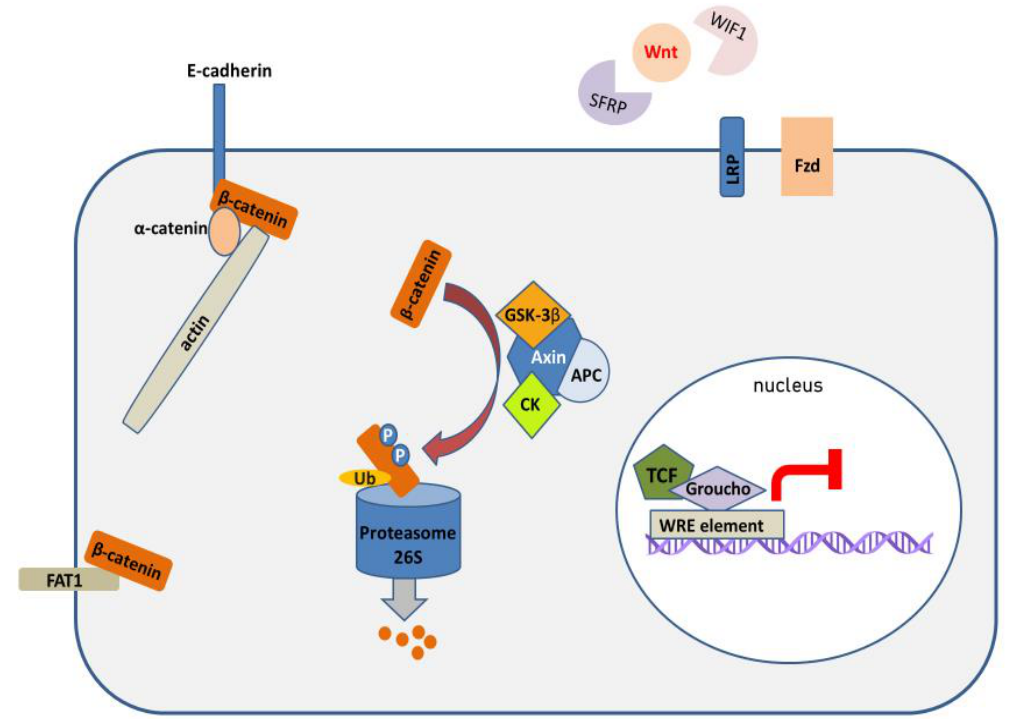
Figure 1. The fates of β-catenin, when the canonical Wnt pathway is not activated. Extracellular Wnt ligands are sequestered by antagonistic proteins (SFRPs, WIF1) and cannot bind to FZD/LRP receptors. Membrane-bound β-catenin takes part in cell-cell adhesion, together with E-cadherin and α-catenin. Cytoplasmic β-catenin is phosphorylated by the components of the destruction complex (CK, GSK-3β) and targeted for ubiquitin-mediated proteasomal degradation, and thus cannot translocate to nucleus and activate transcription. TCF/LEF transcription factors form complexes with suppressors of β-catenin-dependent transcription (e.g., Groucho) and cannot stimulate the expression of WRE-regulated genes. WRE—Wnt response element, CK—casein kinase 1.